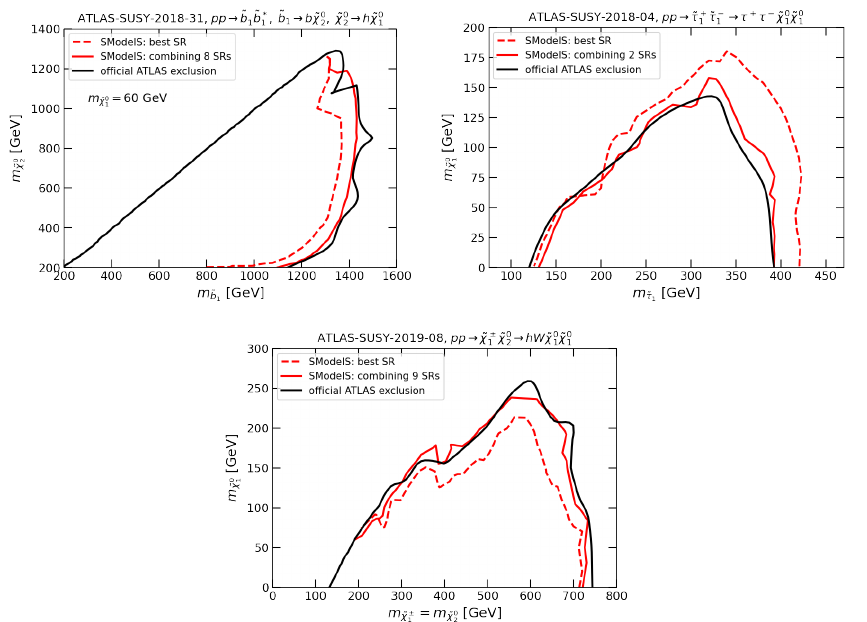
Figure 8: 95% CL limits obtained with SModelS [ 39, 124 ] for three ATLAS anal- s yses using the best SR only (dashed red lines) or combining SRs by means of the background-only statistical models provided by ATLAS [ 20,21,23 ] (full red lines); to be compared to the official exclusion lines from ATLAS shown in black.